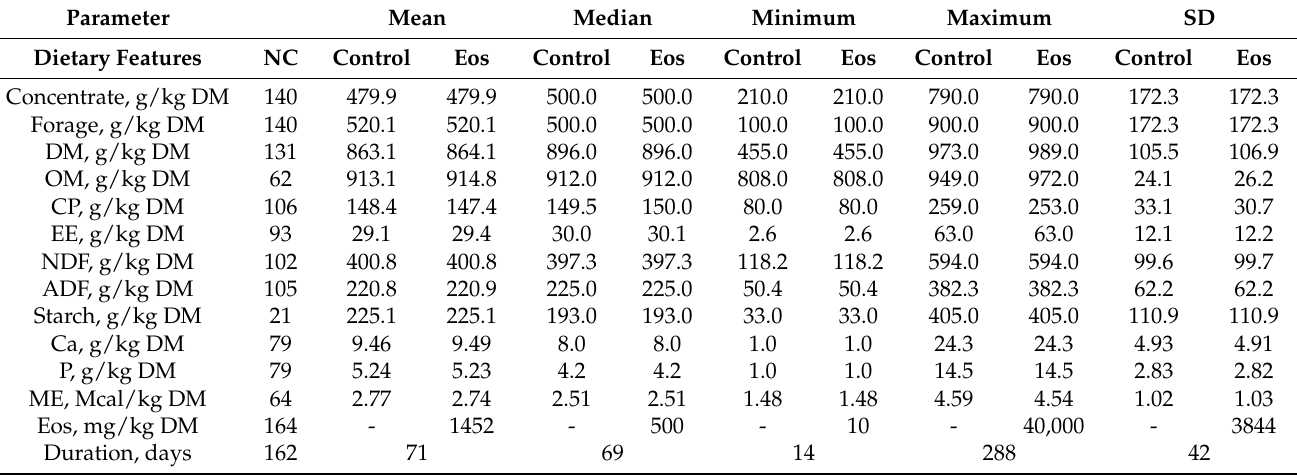
Table 1. Descriptive statistics of the complete data set for the effect of Eos supplementation on beef cattle